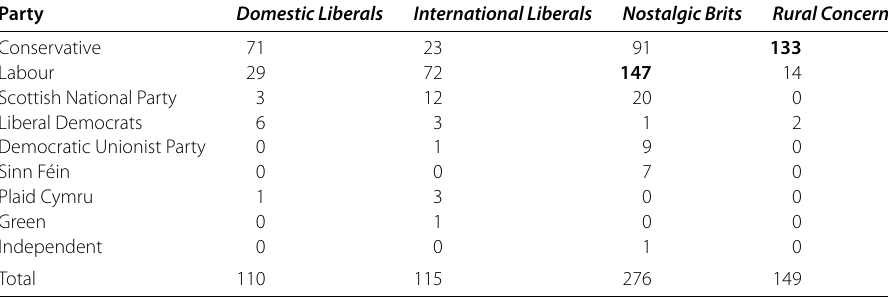
Table 3 Correspondence between 2017 General election results and class membership Party